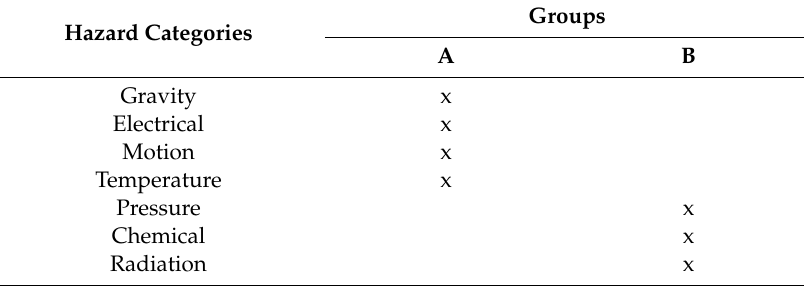
Table 4. Summary results of pair-wise